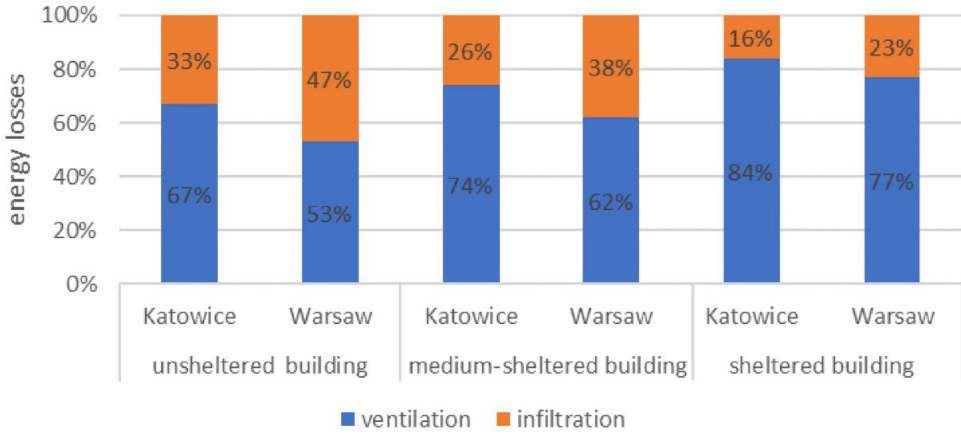
Figure 4. Percentage share of ventilation and infiltration heat losses in total heat losses for ventilation of a building with n 50 = 0.63 located in two cities of Poland for different sheltering conditions